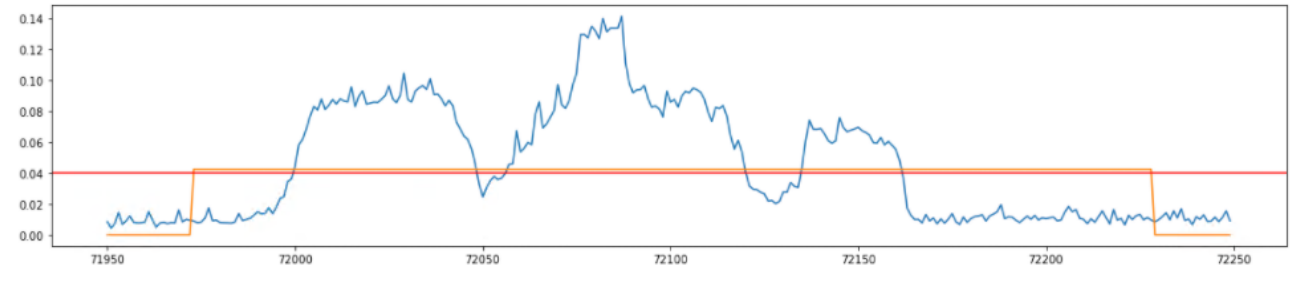
Figure 11. Section 2: 71,950~72,250 (Attack 10). The red line is the threshold, and when the blue line crosses the red line, we predict an attack. The orange line is the actual attack range.